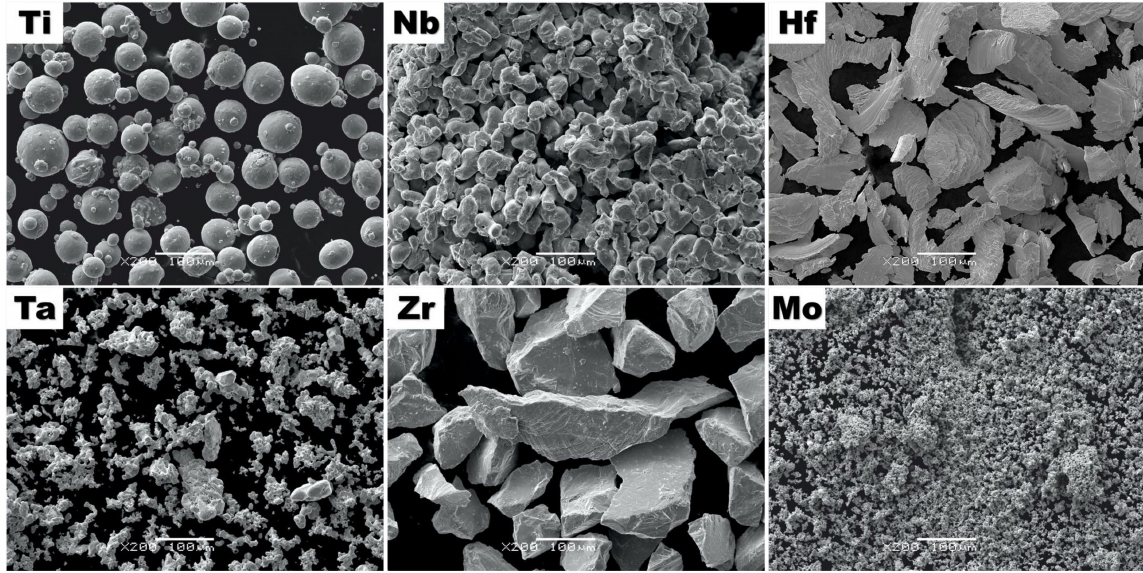
Figure 1. Secondary electron contrast (SEI) microstructure images of Ti, Ta, Nb, Zr, Hf and Mo initial